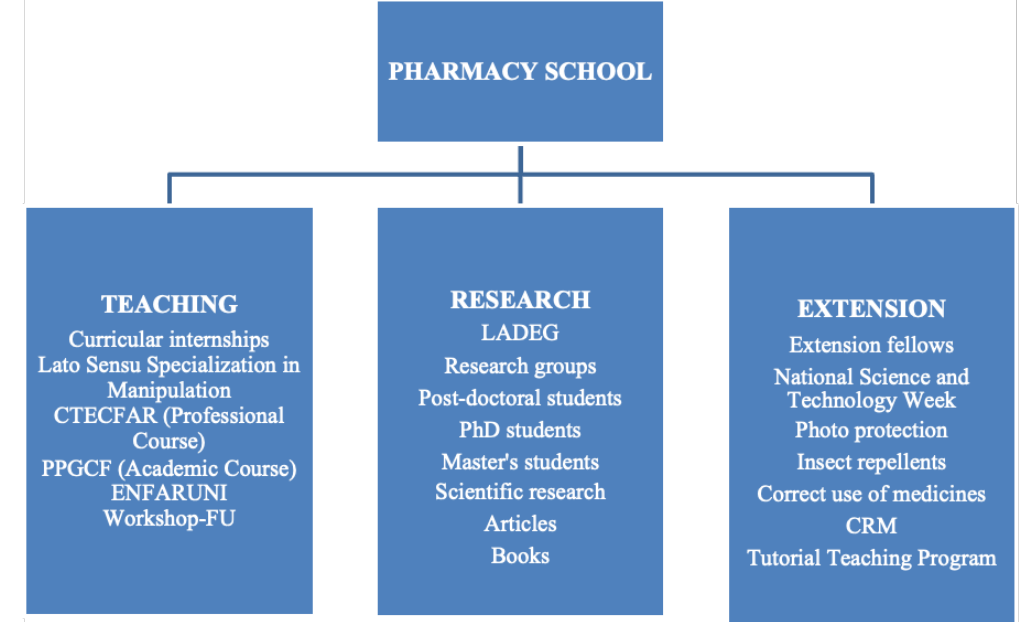
FIGURE 3 - Triad system of FU-UFRJ: teaching, research and